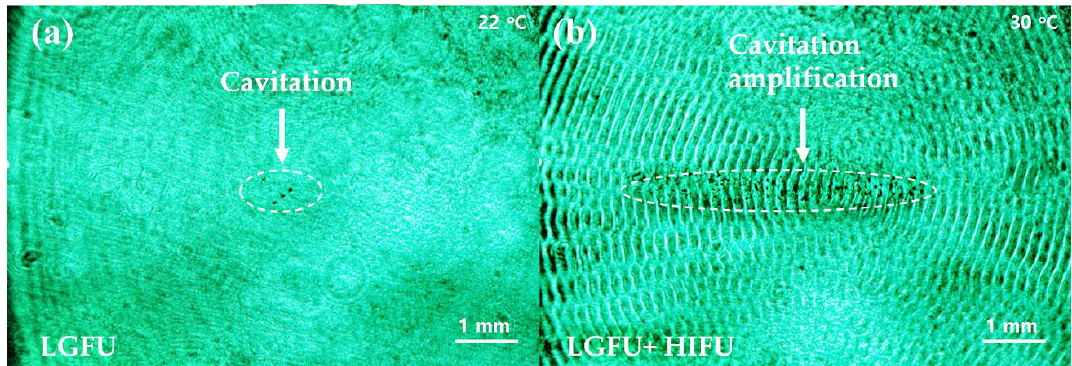
Figure 9. Laser shadowgraphy images for free-boundary cavitation in water: ( a ) a few cavitation bubbles are shown in free boundary in water, generated by LGFU alone; ( b ) by HIFU-induced heating (8 °C), the LGFU-induced cavitation in free boundary was greatly enhanced. The cavitation bubbles are shown over a broad range within the white dotted ellip- ses.